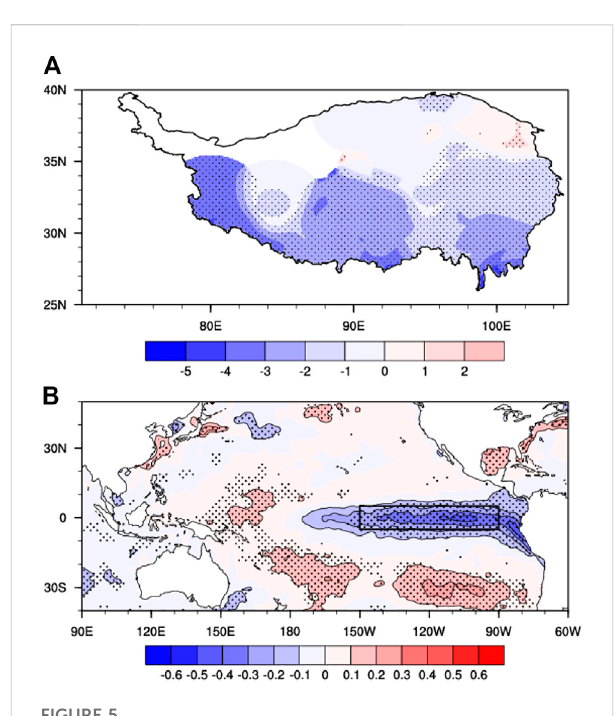
Regressed (A) the spring SH fi eld over TP (units: W · m − 2 ) and (B) the SSTA in preceding winter (December) (units: ° C) on midsummer precipitation in South China. The dotted areas passing the 90% signi fi cance level test; the box indicates the scope of the Niño-3 region in Figure